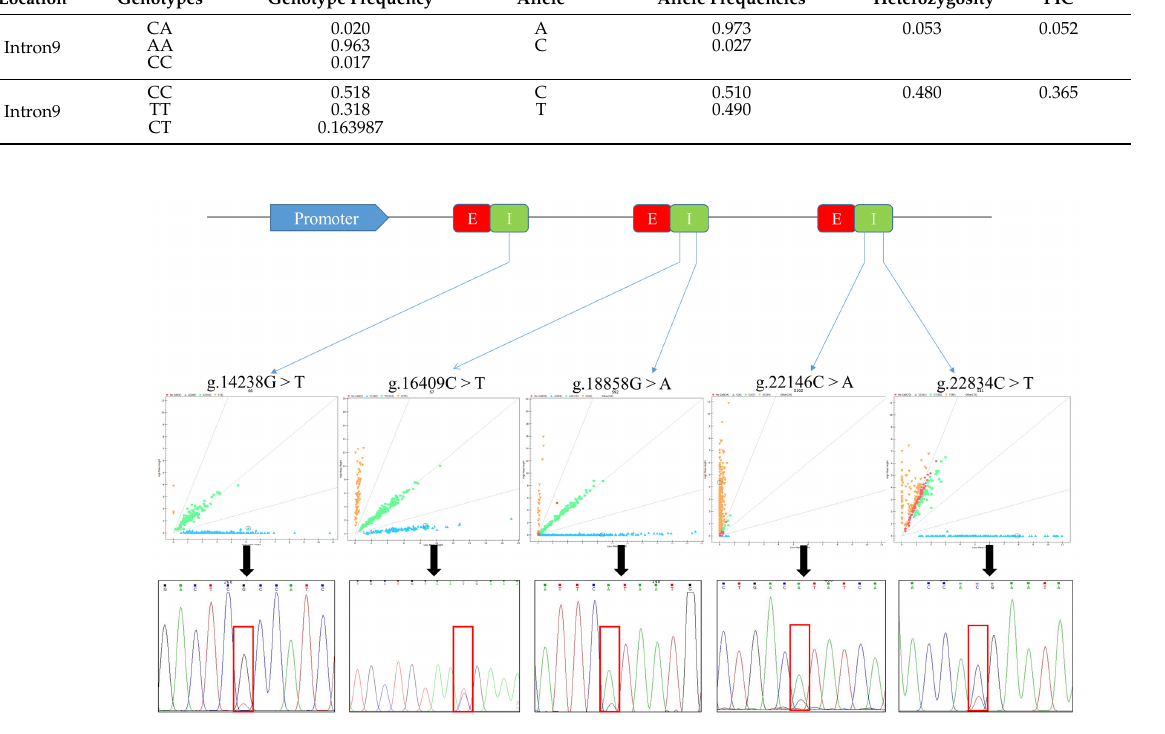
Figure 1. Schematic representation of buffalo SQLE gene with the localization of five identified SNPs and their SNP genotyping plots. E: exon region; I: intron region. Red squares represent mutant loci, different colored lines represent different bases. Table 1. Genetic information about five SNPs identified in the buffalo SQLE gene.